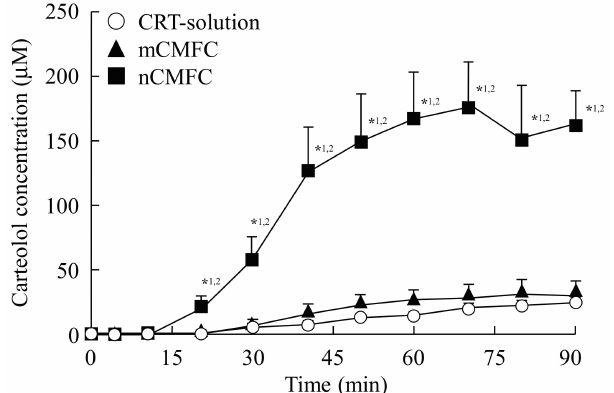
Figure 4. In vivo corneal permeability of carteolol from nCMFC. CRT-solution ( solution-instilled rabbit. mCMFC ( (cid:78) ), mCMFC-instilled rabbit. nCMFC ( (cid:4) ), nCMFC-instilled rabbit. n = 7. * 1 p < 0.05, vs. CRT-solution for each category. * 2 p < 0.05, vs. mCMFC for each category. The carteolol concentration in the aqueous humor of rabbits instilled with nCMFC was significantly higher than in the aqueous humor of rabbits instilled with CRT-solution or